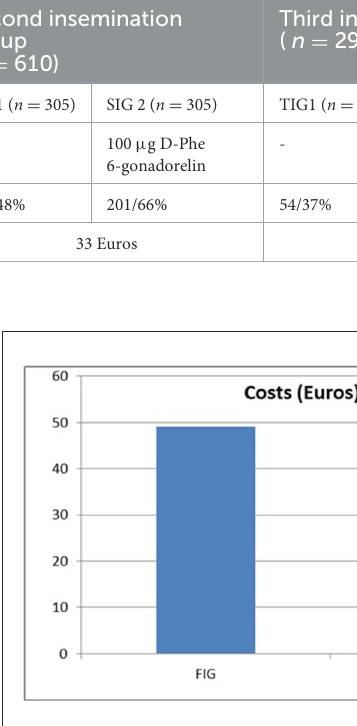
FIGURE2 Cost with GnRH administration to obtain 1